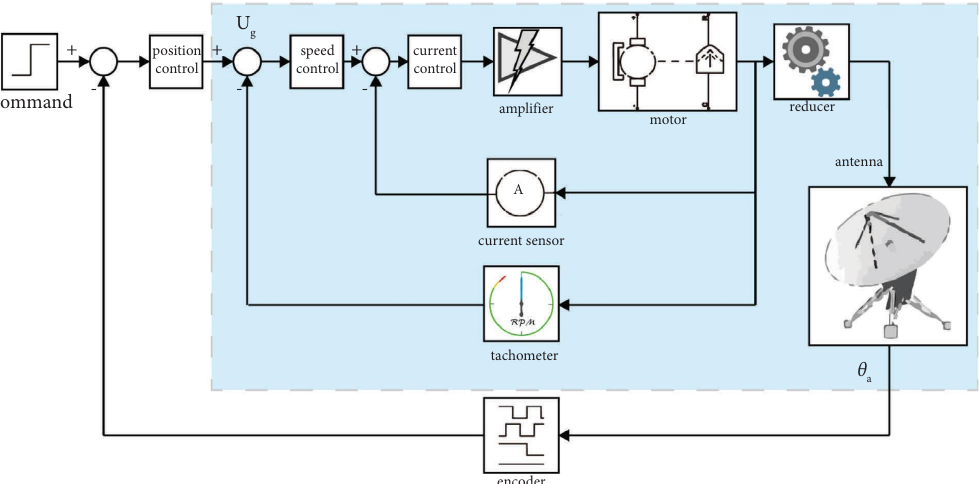
Figure 2: Te three-loop control structure of the antennas.